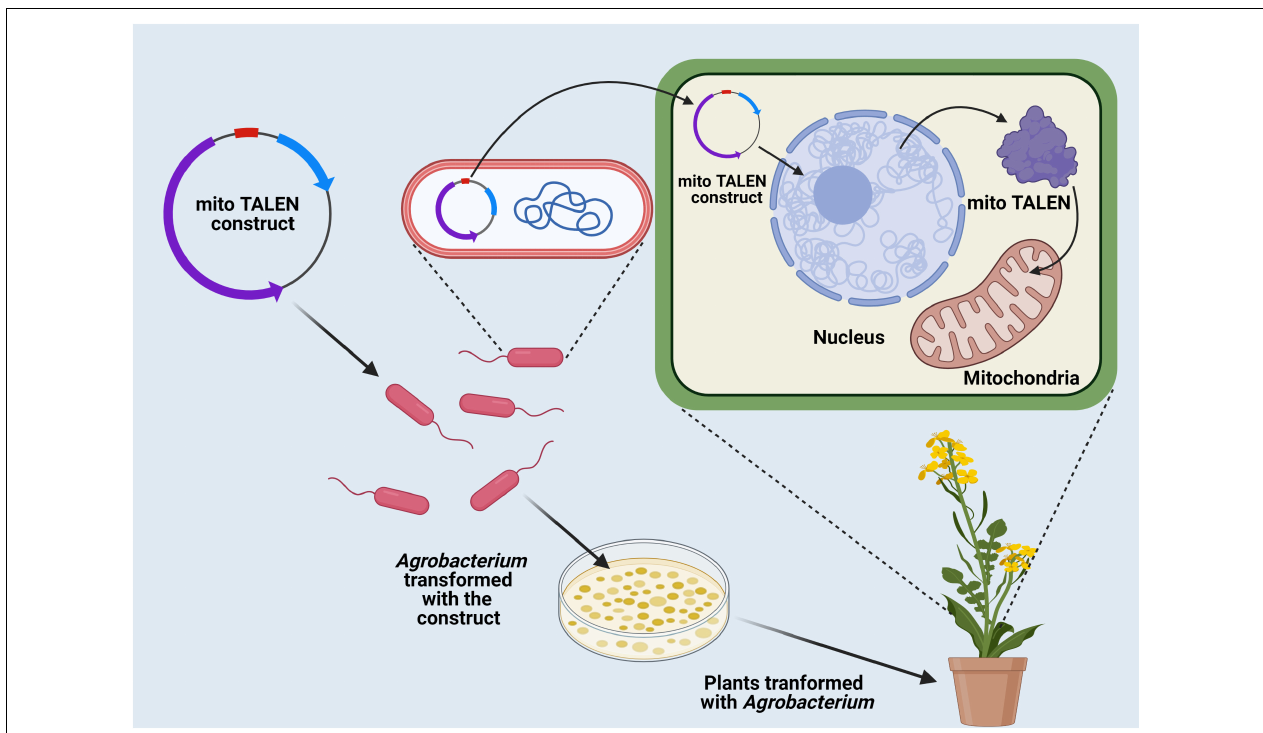
FIGURE 6 | Transformation of the mitochondrial genome. Genome editing in mitochondria through transcription activator-like editing nucleases (TALEN) mediated nuclear transformation and generated new types of crop plants with improved